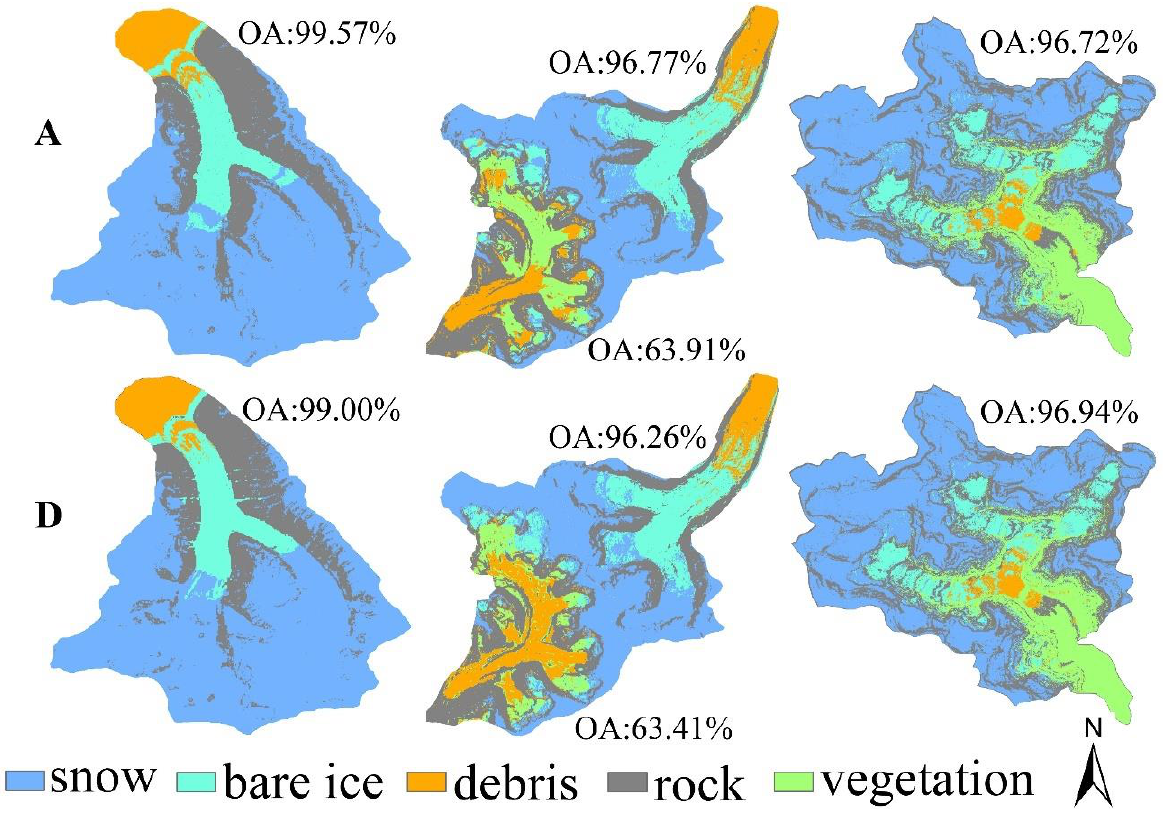
Figure 10. Classification results of the four glaciers from the two PDP data suites of both ascending ( A ) and descending ( D ) nodes.